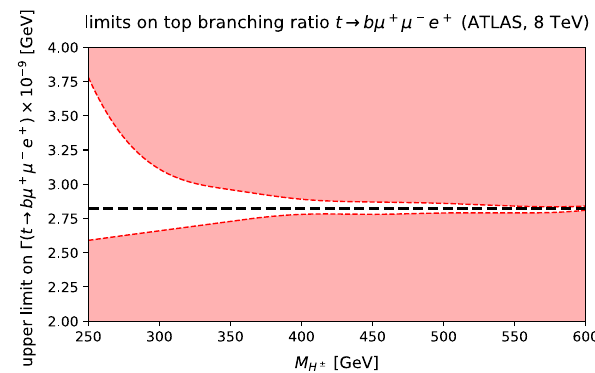
that 140 GeV < M (cid:5) < 180 GeV after the mass drop condi-